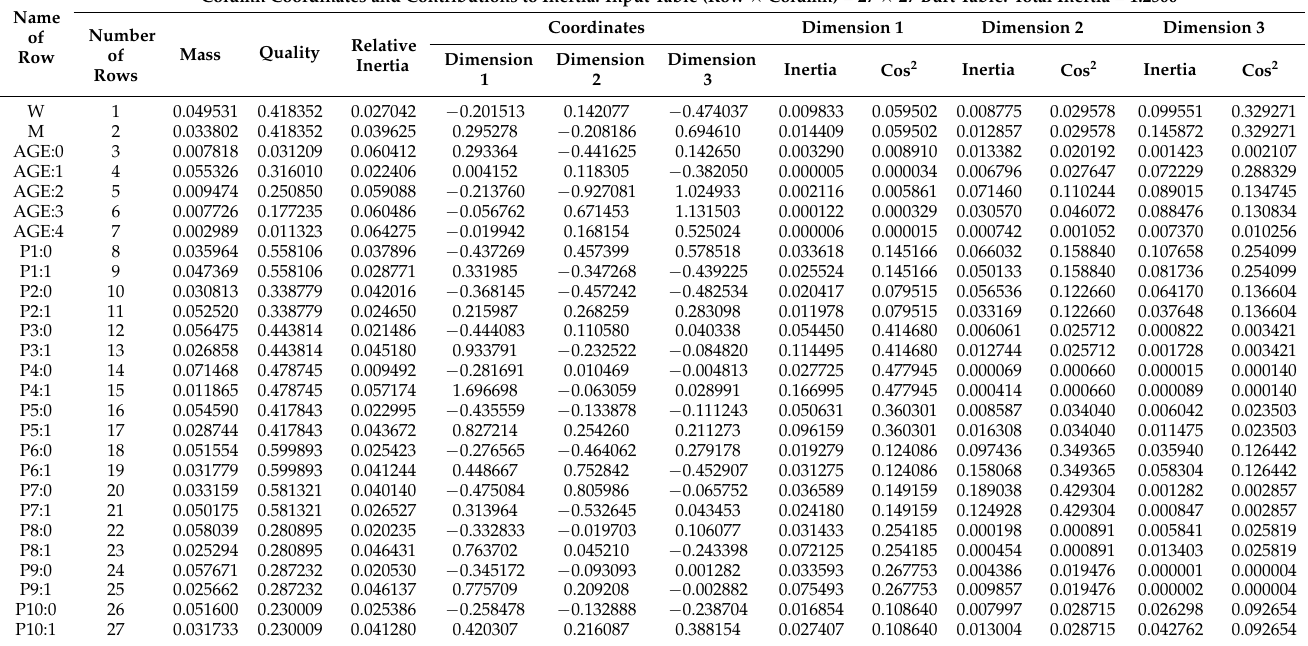
Table 6. Coordinates of columns and the statistics of the quality of the